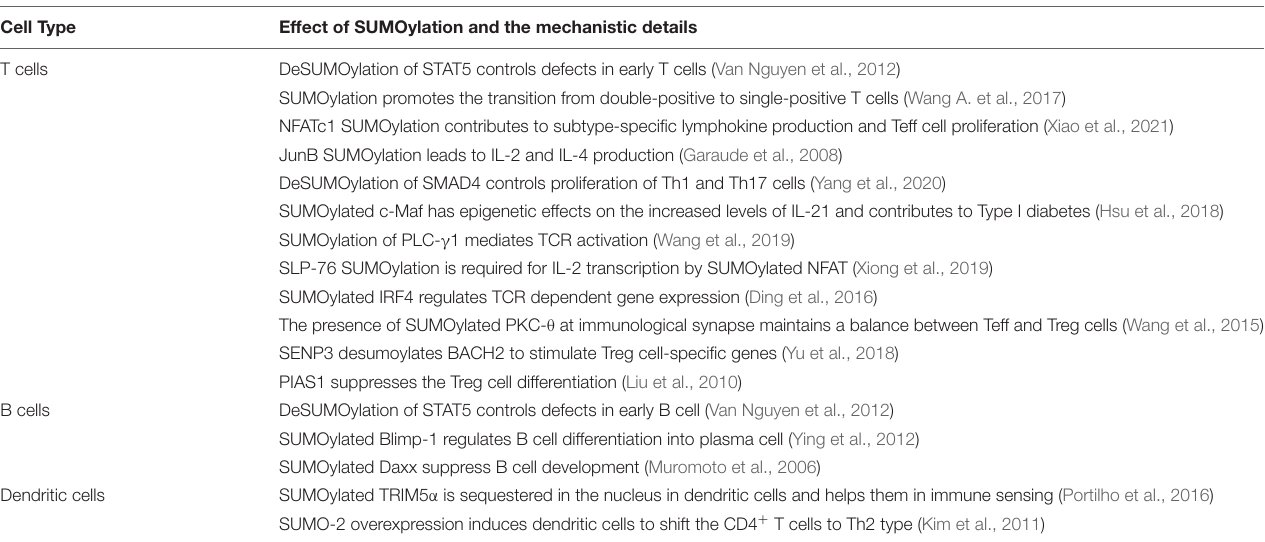
TABLE 1 | Mechanism and effects of immune cell protein